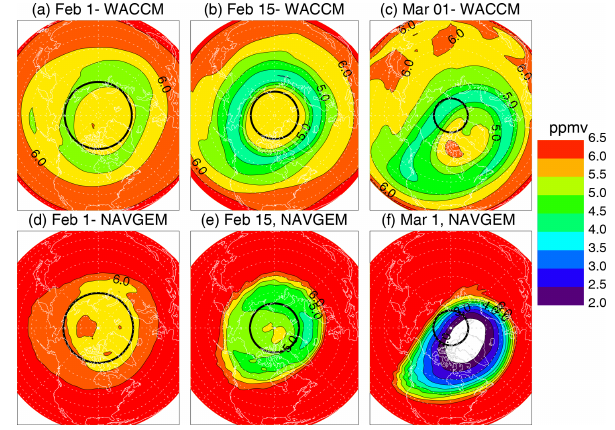
Figure 6. Polar projections at 0.32hPa of H 2 O from WACCMX (a–c) and NAVGEM-HA (d–f) for the indicated dates. The contour interval is 0.5ppmv. The brightest red is greater than 6.5ppmv, and the white in the NAVGEM-HA field for 1 March represents val- ues less than 2.0ppmv. The black rings in each panel represent the occultation latitudes for SOFIE for each date. The polar plots are oriented such that a longitude of 90 ◦ W is at the